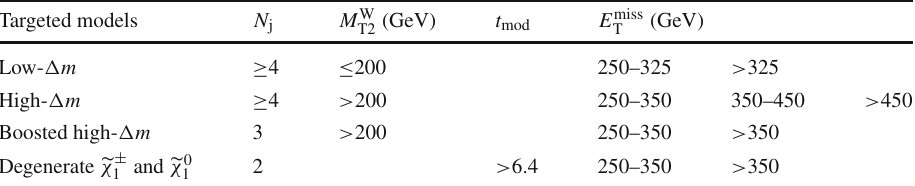
Table 3 Summary of the SR definitions for the single-lepton